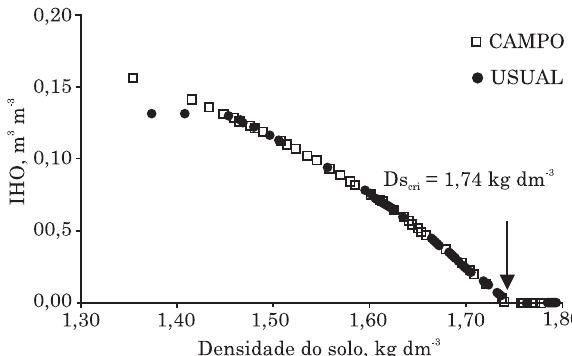
Figura 5. Variação do Intervalo Hídrico Ótimo (IHO) nas diferentes densidades do solo utilizando duas estratégias (CAMPO e USUAL)